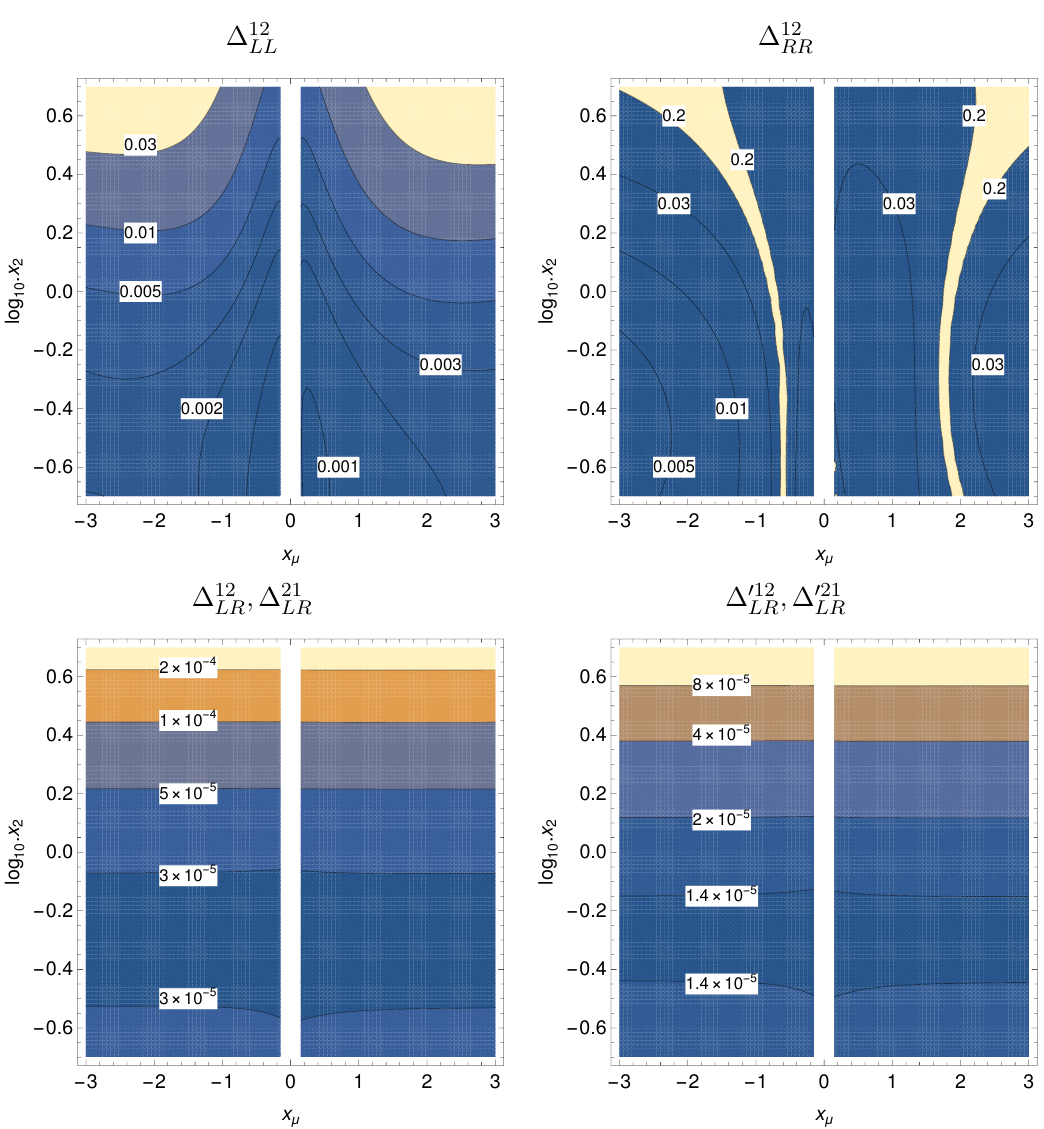
Figure 10 . Upper bounds on the LFV parameters using the current experimental limit on the Br( (cid:22) ! e(cid:13) ) for degenerate slepton masses M = 800 GeV as a function of mass splitting between the gaugino and the (cid:22) related parameters, x (cid:22) = (cid:22)=M , x 2 = M 1 =M = M 2 =M